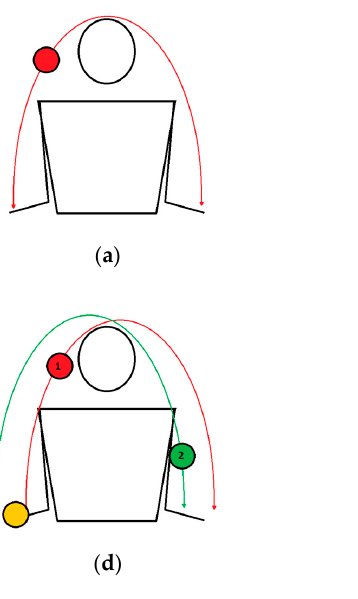
Figure 3. Various juggling exercises: ( a ) the one-handed parabola; ( b ) the one-handed parabola, with the second ball in a catching hand; ( c ) two-handed parabolas with a different focus of attention; ( d ) two-handed parabolas with three balls; ( e ) the zero throw.